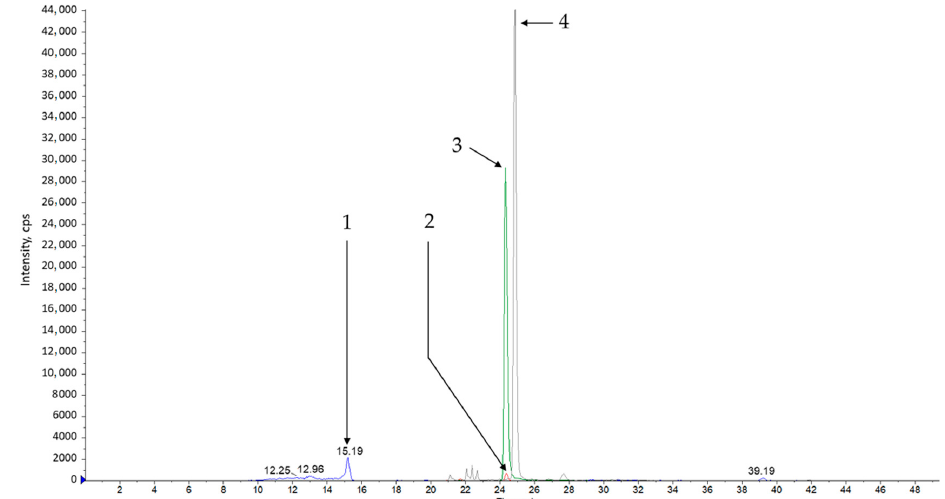
Figure 4. Example of chromatogram XIC obtained for a sample of extract of salvia harvest 1 drying naturally. The chromatogram was obtained for the maximum absorbing wavelength at each time point. (1) catechin C 13 (IS) (m/z = 291.4/291.4); (2) hesperidin (m/z = 300.7/163.8); (3) quercethin (m/z = 301.03/178.9); (4) isorhamnetin (m/z = 314/300).